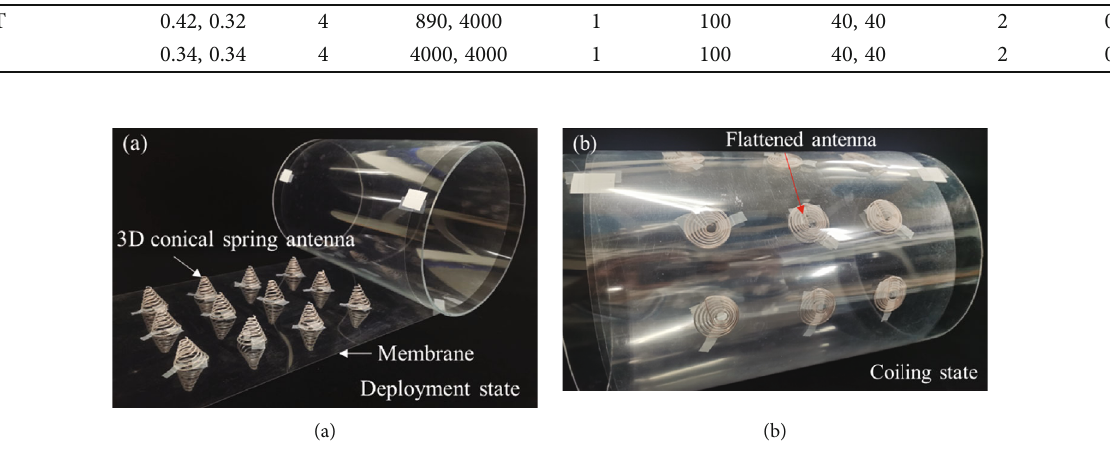
Figure 5: Prototype of the fabricated fl exible coilable antenna array.